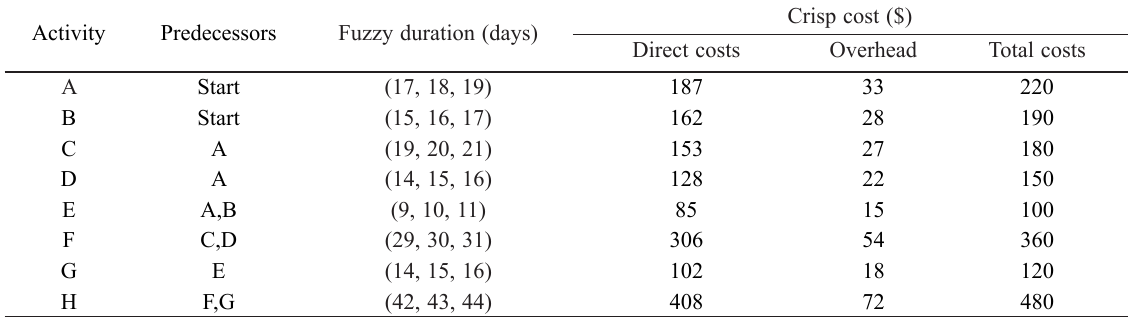
Table 2. Sample activity network